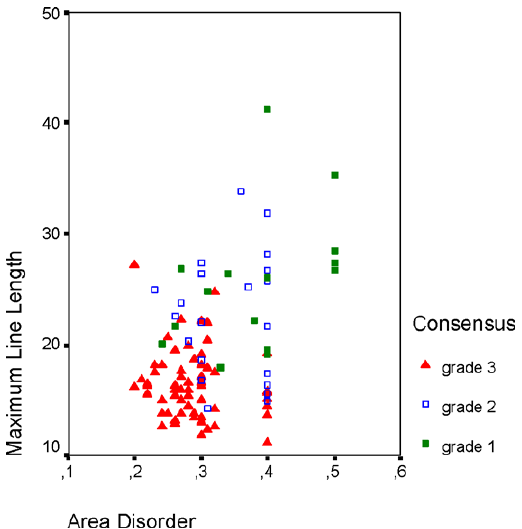
Fig. 3. Scatterplot of the maximum MST line length and the area disorder for the CIN1, CIN2 and CIN3 cases. The variables chosen were the two most discriminating ones in the multivariate stepwise regression analysis.